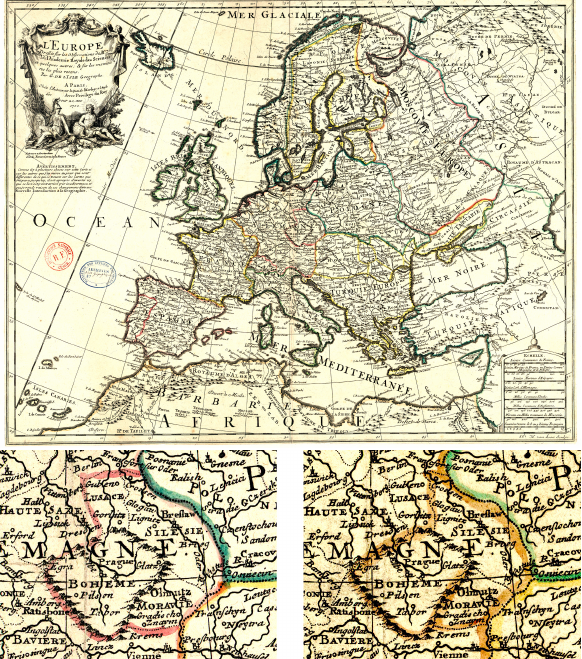
Figure 8: Guillaume Delisle, 1700, L’Europe : Same engraving, different water-colour